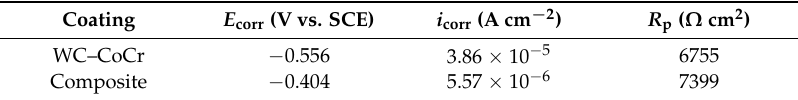
Table 2. Electrochemical parameters derived from the polarization curves of the as-sprayed coatings in 3.5 wt % NaCl solution.